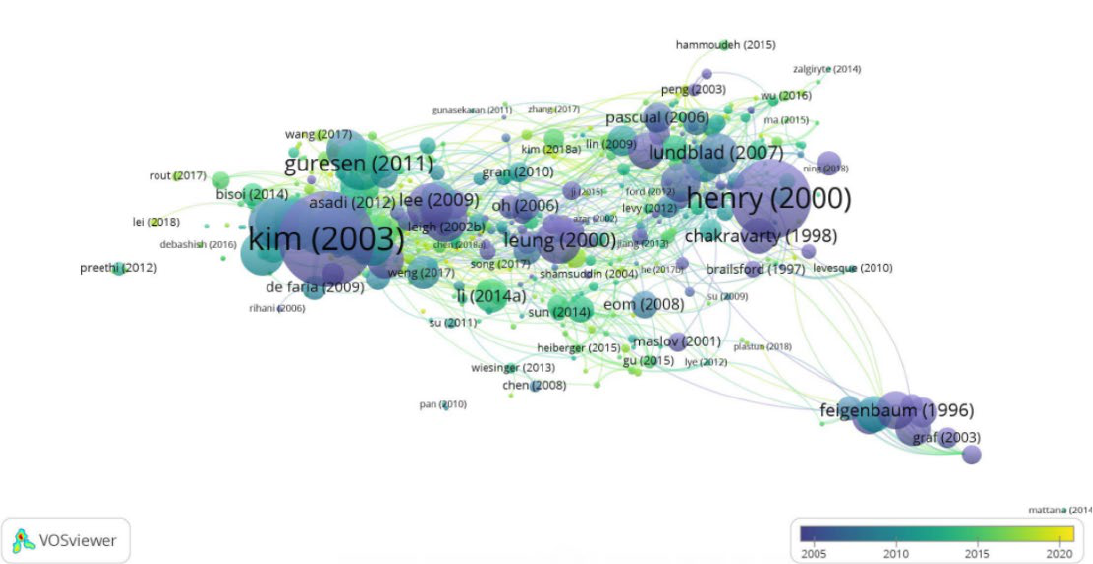
Fig. 2. Bibliographic coupling (source: VOSViewer).